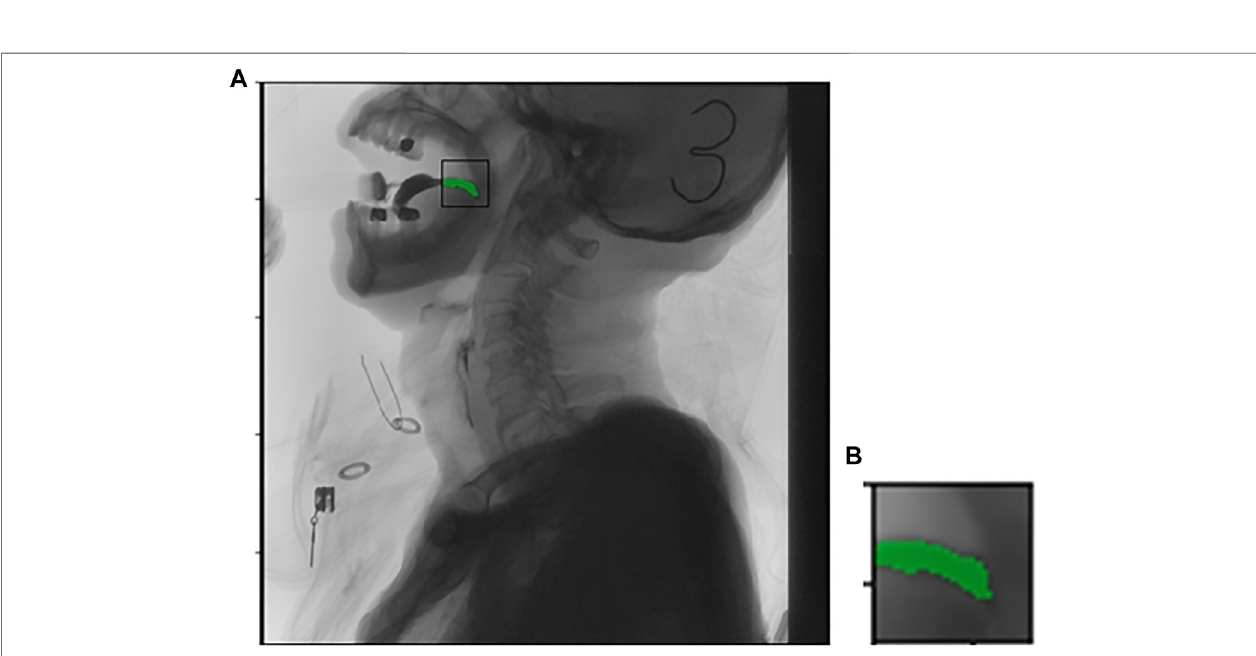
FIGURE 2 | Picture (A) is the original imagine, picture (B) is the targeted area intercepted.